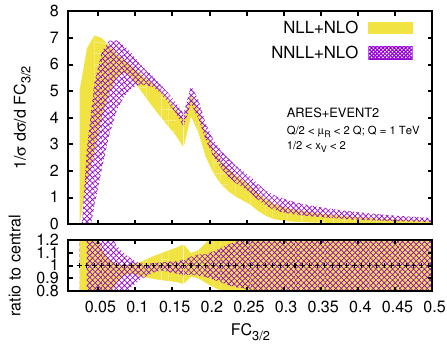
Figure 4 . NNLL+NLO and NLL+NLO distributions for the moment of EEC FC The lower inset shows the ratio to the relative central